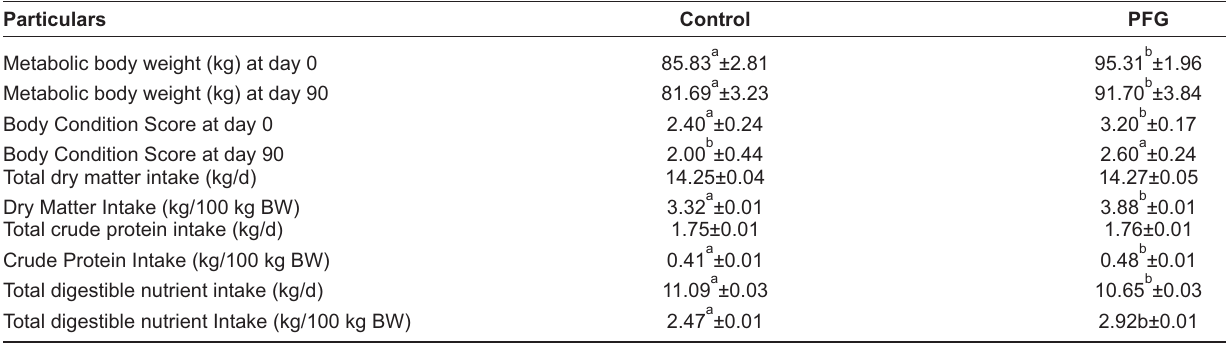
Table-2: Body weight, BCS and nutrients intake in control and prill fat fed (PFG) cows during mid lactation Particulars Metabolic body weight (kg) at day